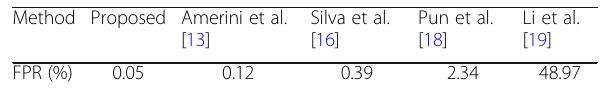
Table 10 Detected results for D3 dataset Method Proposed Amerini et al.